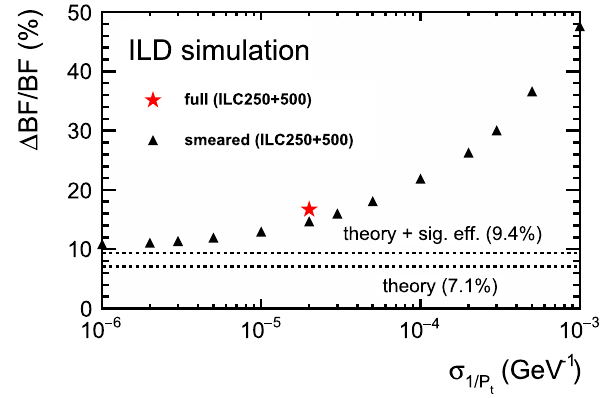
(triangles), together with full t √ s = 500